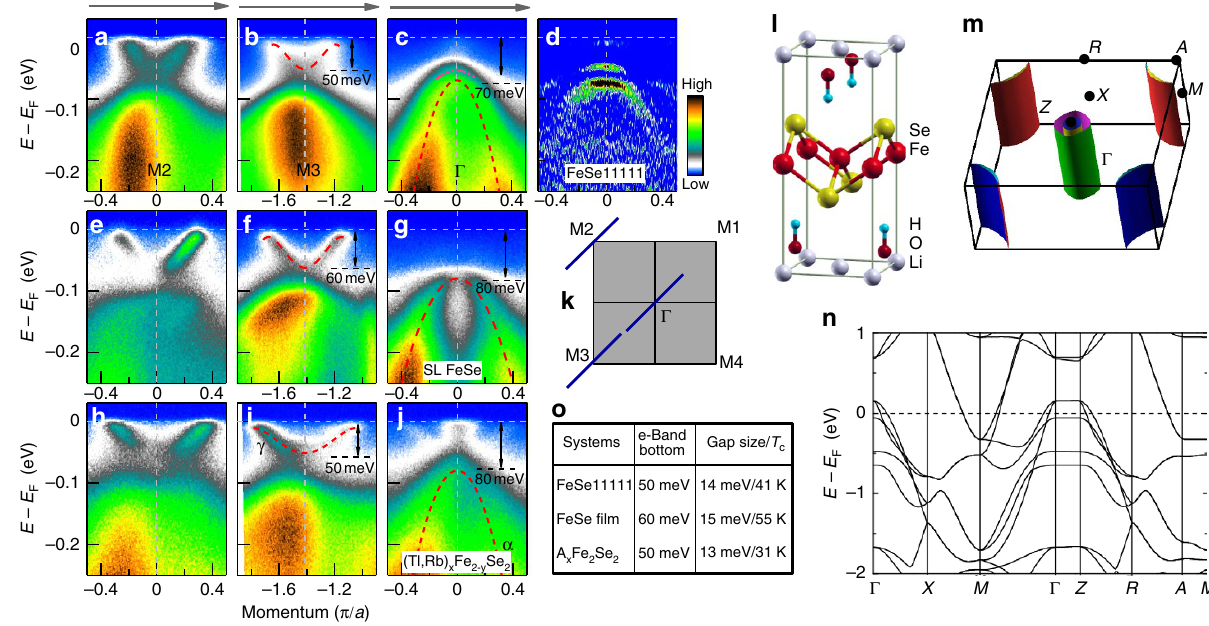
Figure 2 | Band structure and photoemission spectra of (Li 0.84 Fe 0.16 )OHFe 0.98 Se superconductor measured along high-symmetry momentum cuts. ( a - c ) Photoemission images of (Li 0.84 Fe 0.16 )OHFe 0.98 Se measured at a temperature of 20K along three high-symmetry cuts, G cut, M2 cut and M3 cut, respectively. ( d ) The second-derivative image of c with respect to the energy, to reveal the band structure better. For comparison, e – j show photoemission images of a superconducting single-layer FeSe/SrTiO 3 film and (Tl,Rb) x Fe 2 (cid:2) y Se 2 measured along the same G cut, M2 cut and M3 cut, respectively. The location of the three momentum cuts are shown in k . The red dashed lines in a – j images are the guide to the eyes for the observed band structures. ( l – n ) DFTcalculation results. ( l ) The crystal structure for the DFTcalculation. ( m ) The Fermi surface and band structures along high symmetry directions are shown in n . In o , the table lists the bottom position of the electron band near M, the superconducting gap size and corresponding T c for these three systems. The gap size for FeSe11111 will be obtained in Fig.